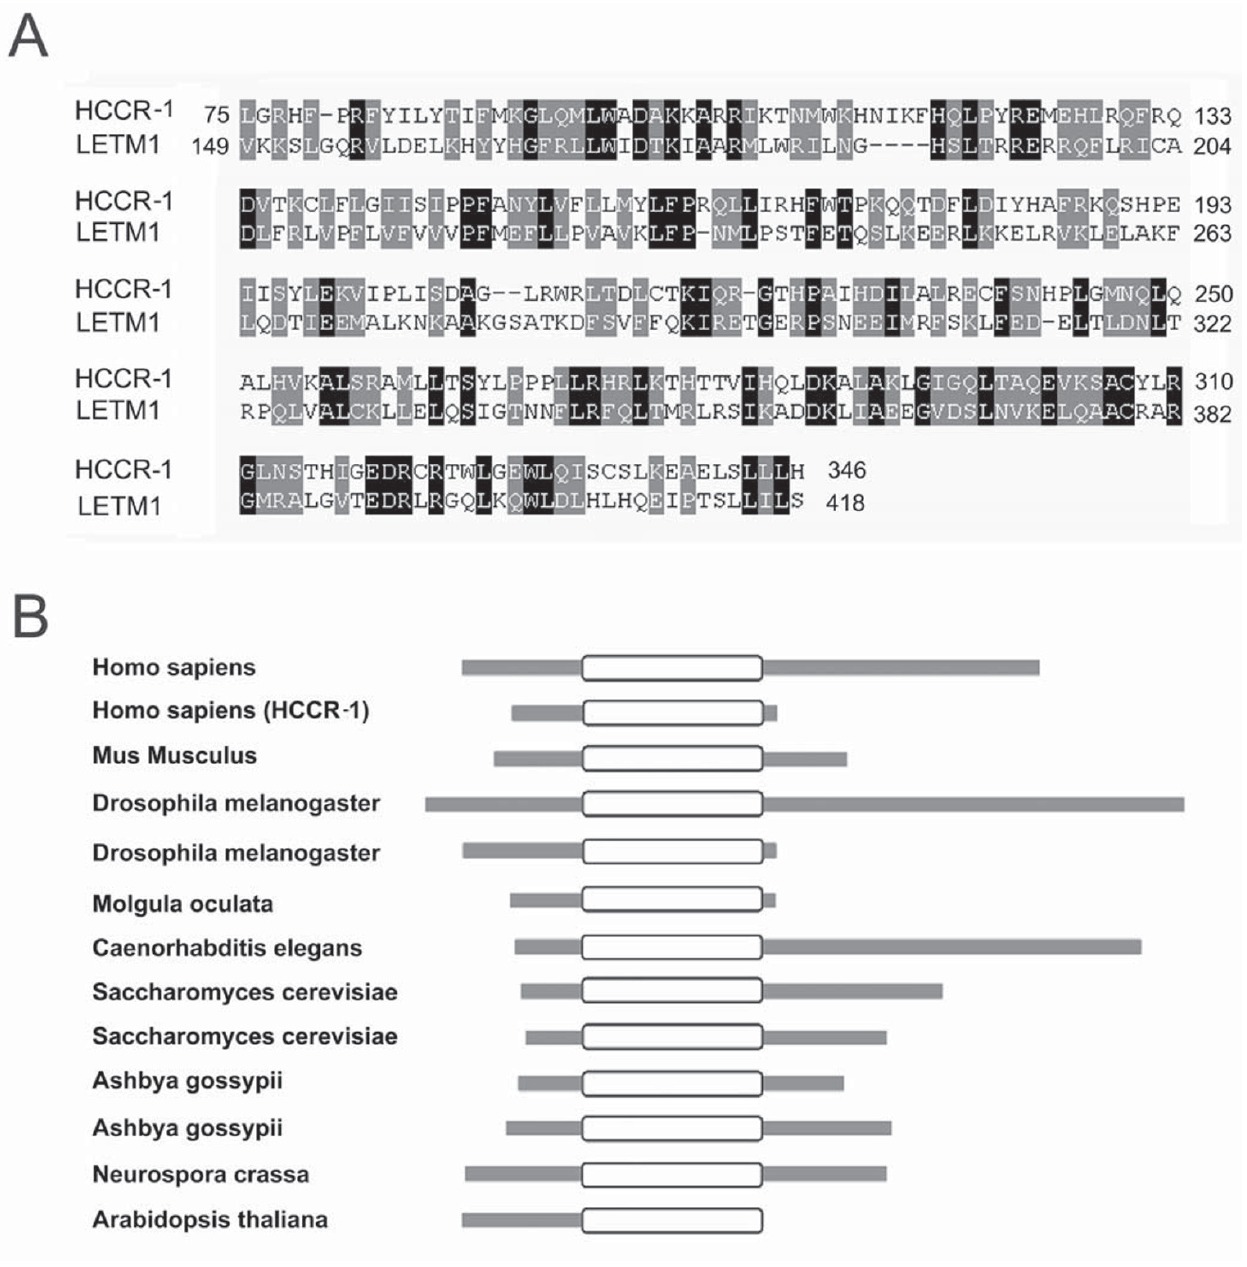
Figure 1 Alignments of HCCR-1 with its homologs . (A) Alignment of HCCR-1 with Human LETM1 protein (gi18204589 ref AAH21208). Identities are highlighted in black and conserved substitutions by gray. (B) Schematic alignment shows the LETM1 domain structure. Analysis using Pfam revealed sequence similarity with the LETM1 domains. Scale is lengths proportional to their molecular masses. The locations of putative LETM domains are indicated by blank boxes. Homo sapiens gi18204589 ref AAH21208; Homo sapiens (HCCR-1) gi13624098 ref AAK34885; Mus musculus gi33416955 ref AAH55685; Drosophila